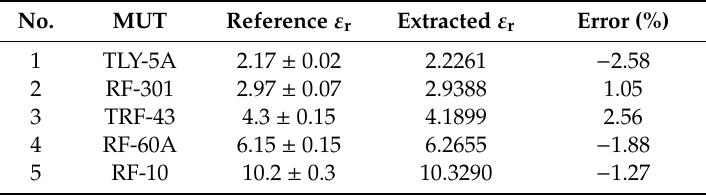
Table 4. Comparison of extracted relative permittivity for the five